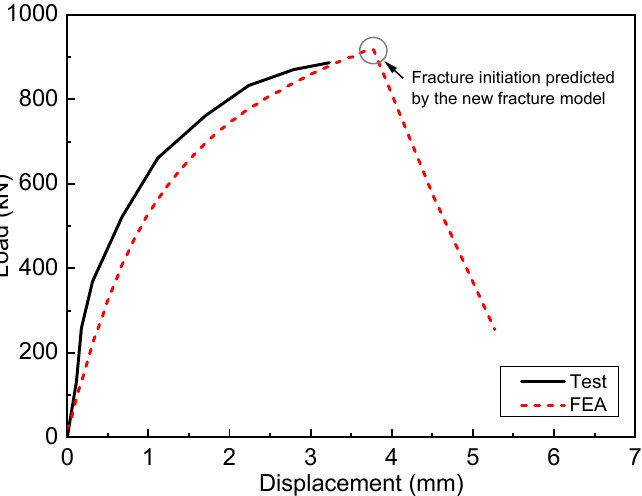
Figure 11. Load–displacement of the X90-2 specimen obtained from the test and finite element analysis.